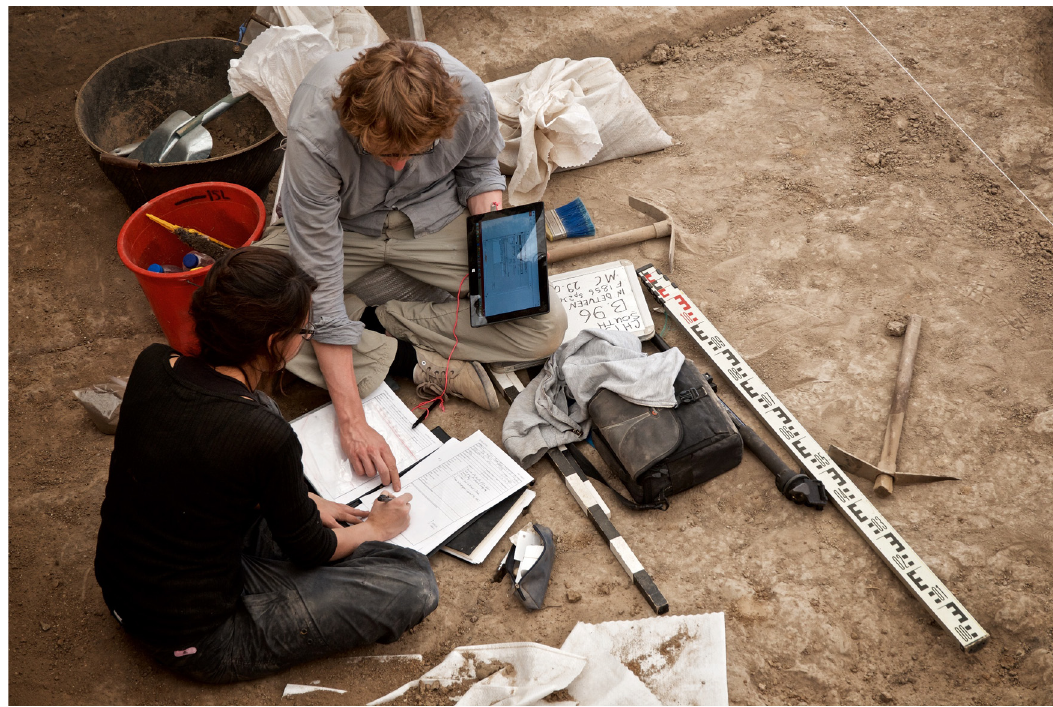
Figure 2: A site in transition – re fl exive ( ? ) discussion over analogue records at Çatalhöyük ’ s “ trowel ’ s edge, ” with the aide